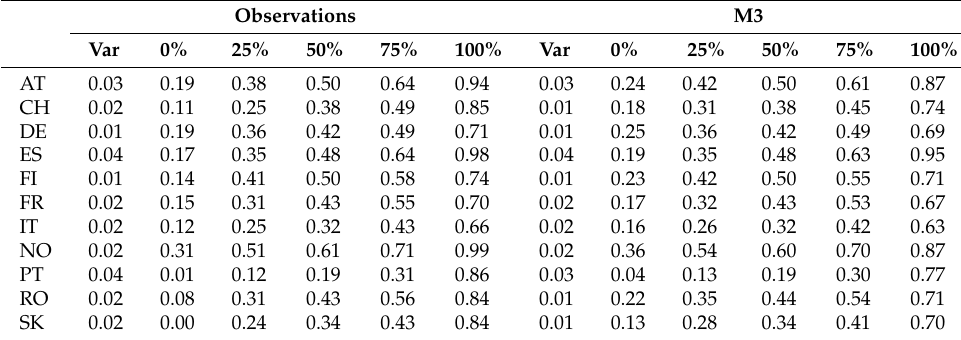
Table A2. Time series quality